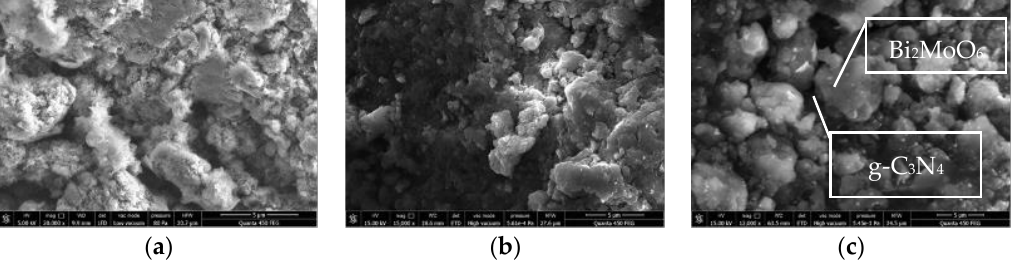
Figure 1. SEM images of ( a ) g-C 3 N 4 , ( b ) Bi 2 MoO 6 and ( c ) 1:32 Bi 2 MoO 6 /g-C 3 N 4 . The XRD analysis of g-C 3 N 4 , as depicted in Figure 2, reveals two distinct peaks in the vicinity of 2 θ values of 13.0 ◦ and 27.4 ◦ . The peak located at approximately 13.0 ◦ corresponds to the (100) crystal plane of g-C 3 N 4 , while the peak located at approximately 27.4 ◦ corresponds to the (002) crystal plane. These peaks are in an agreement with the characteristic XRD spectrum of g-C 3 N 4 (JCPDS 87-1526). In the case of Bi 2 MoO 6 , the XRD analysis reveals several distinct peaks at 2 θ values of 27.361 ◦ , 31.705 ◦ , 32.562 ◦ , 45.481 ◦ , 53.905 ◦ , 56.441 ◦ , and 66.429 ◦ which corresponded to the (131), (200), (151), (202), (331), (262), and (004) crystal planes, respectively, of orthorhombic Bi 2 MoO 6 as per the standard card (JCPDS No.76-2388). The XRD analysis of the 1:32 Bi 2 MoO 6 /g-C 3 N 4 composite reveals the characteristic peaks of both g-C 3 N 4 and Bi 2 MoO 6 . The peaks of Bi 2 MoO 6 (131), (200), (151), (202), (331), and (262) are particularly pronounced, and no other impurities were detected. This indicates that the 1:32 Bi 2 MoO 6 /g-C 3 N 4 composite has been prepared successfully.